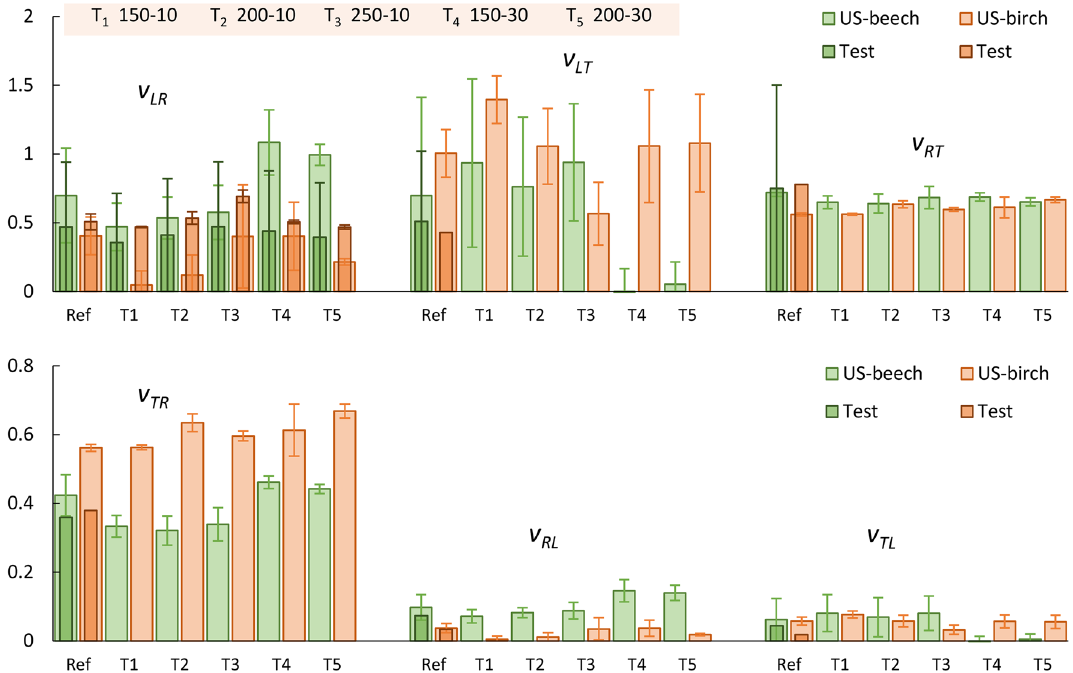
Figure 11. Mean values for the Poisson’s ratios of reference and heat-treated beech & birch obtained by ultrasound and quasi-static